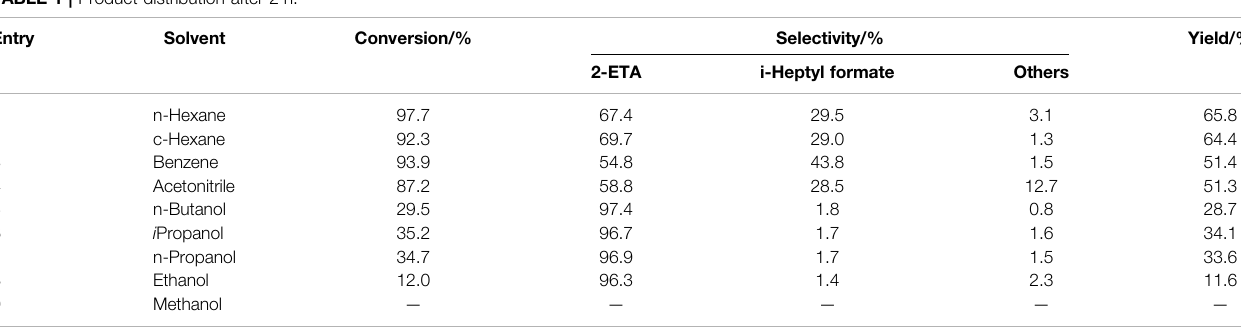
TABLE 1 | Product distribution after 2